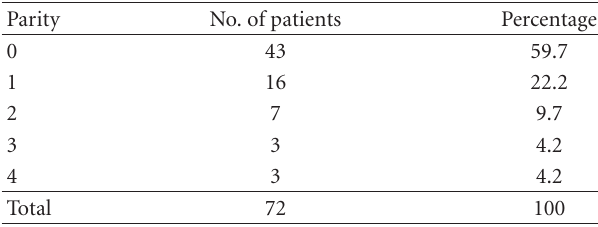
Table 2: Parity distribution of patients with IUA.